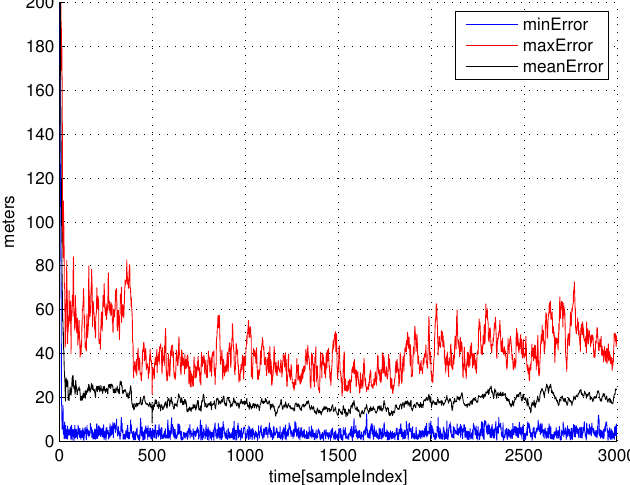
Figure 5. The enlarged figure of Figure 4. We plot meanE k , maxE k , and minE k with respect to sample-index k . Since we utilize the bearing measurements of three ships, the estimation error is small from the beginning of the scenario (three ships